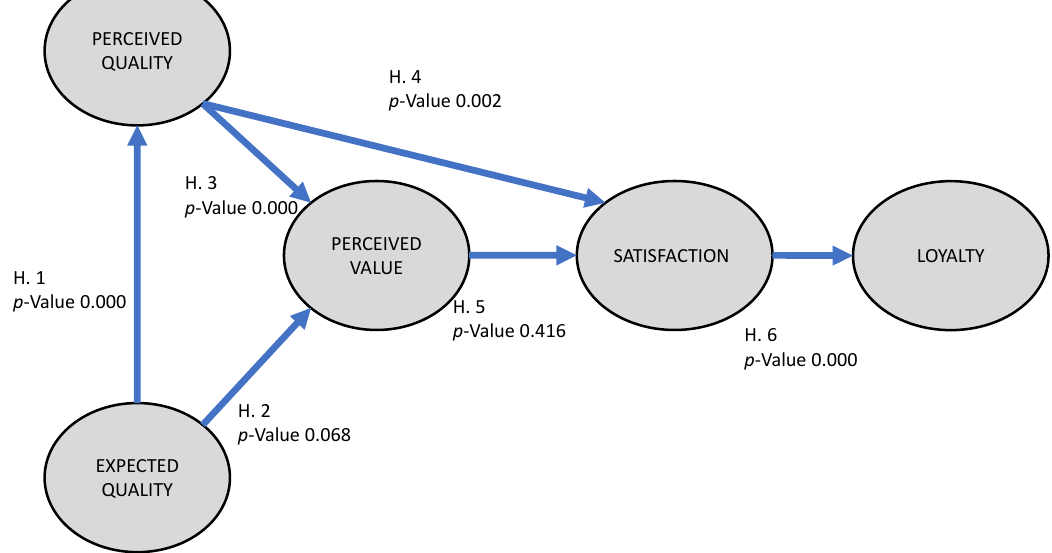
Figure 3. Path diagram of the proposed model with the p value.